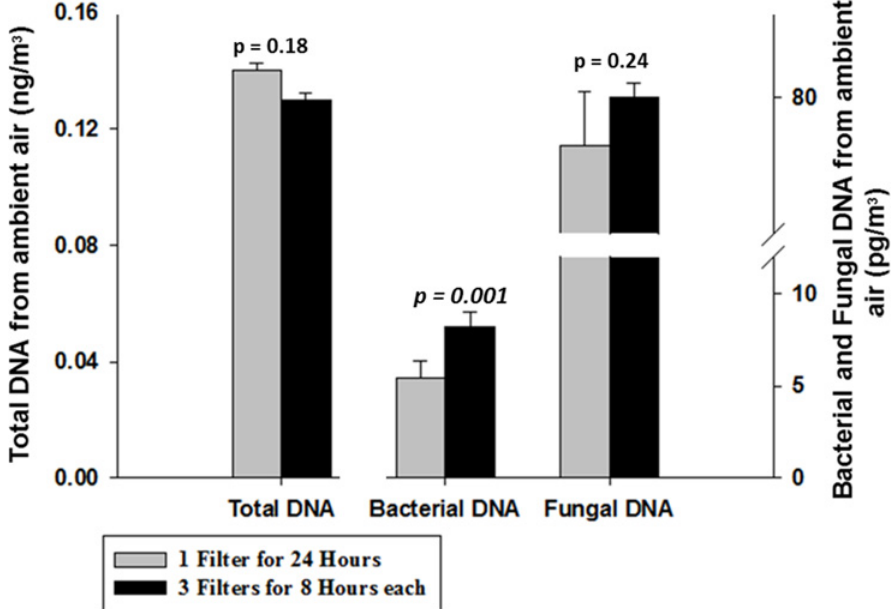
Fig 5. Comparison of two sampling approaches. Comparison of a sampling approach utilizing a single filter continuously sampled for 24 h (grey bar) and a combined series of three filters, each operated for 8 h (black bar) expressed in terms of total DNA (left bar, left axis) measured by Qubit and in terms of bacterial (middle bar, right axis) and fungal (right bar, right axis) DNA measured by qPCR ( N = 3).